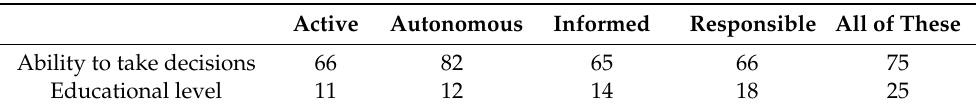
Table 1. Description of empowerment for nurses using the ability to make decisions and educational level as measures of empowerment (%). Active Autonomous Informed Responsible All of These Ability to take decisions 66 82 65 66 75 Educational level 11 12 14 18